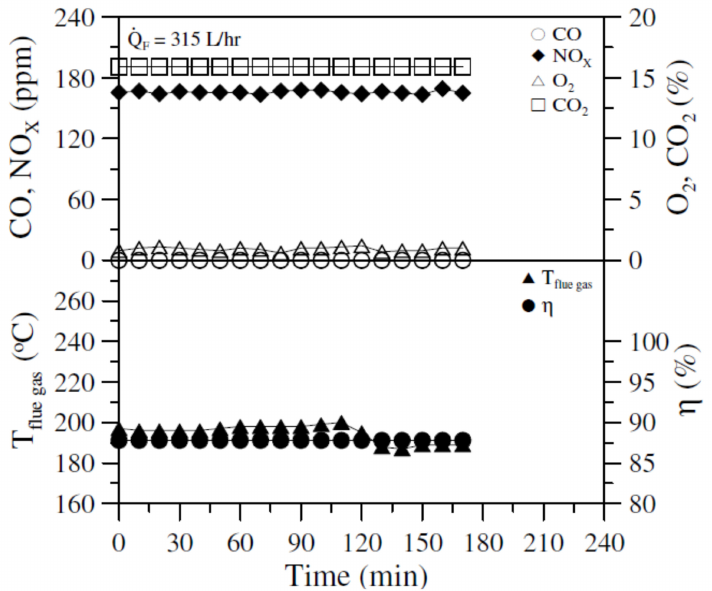
Figure 9. Combustion characteristics when firing emulsion fuel oil with 20 vol% water without cleaning the boiler